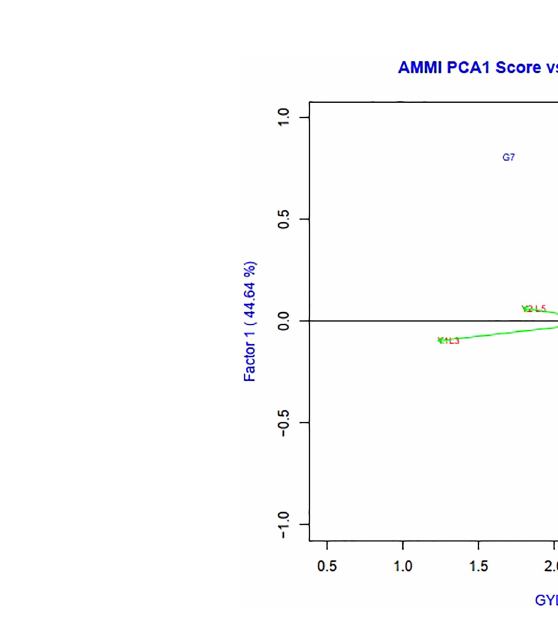
FIGURE 3 The biplot ‘ AMMI 1 ’ illustrated the trait main effect and fi rst interaction principal component (IPC1) effects of both genotype and environment of 11 soybean genotypes under two years (11 environments) for grain yield per hectare. The biplots were created based on Centering = 0, SVP = 2, Scaling = 0.